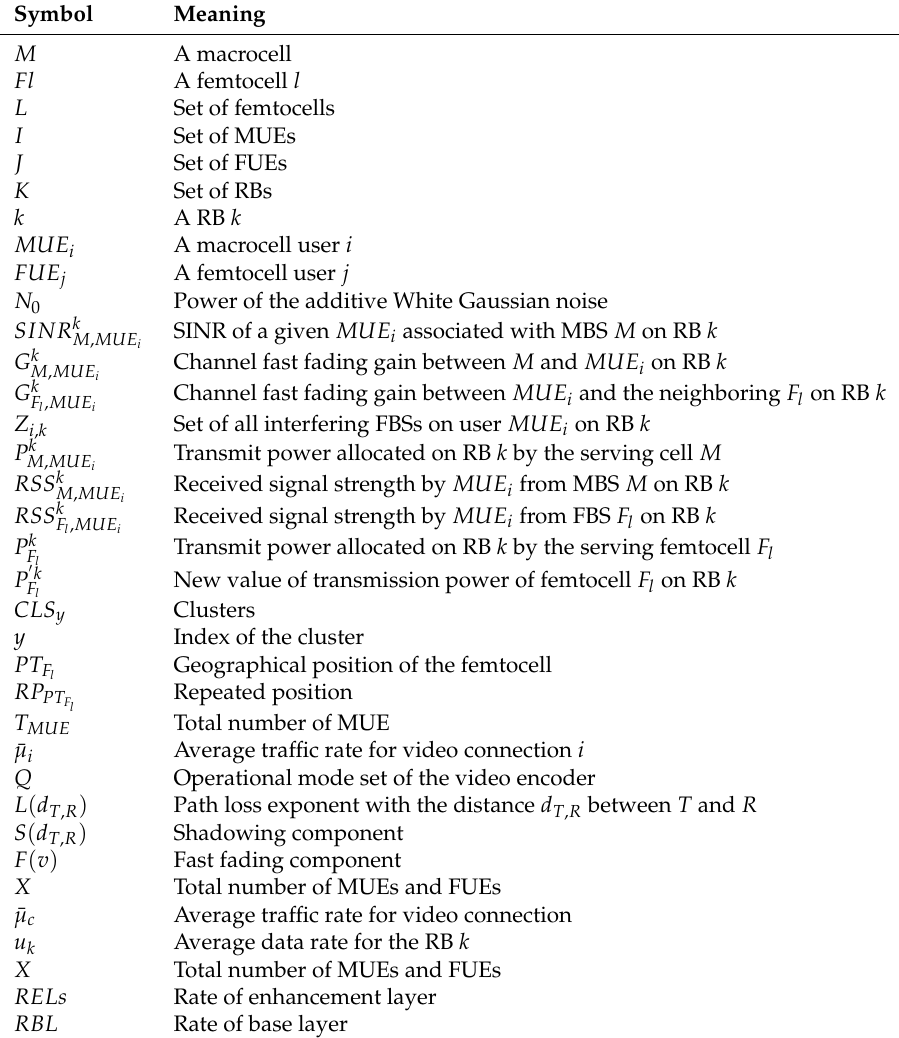
Table 2. List of